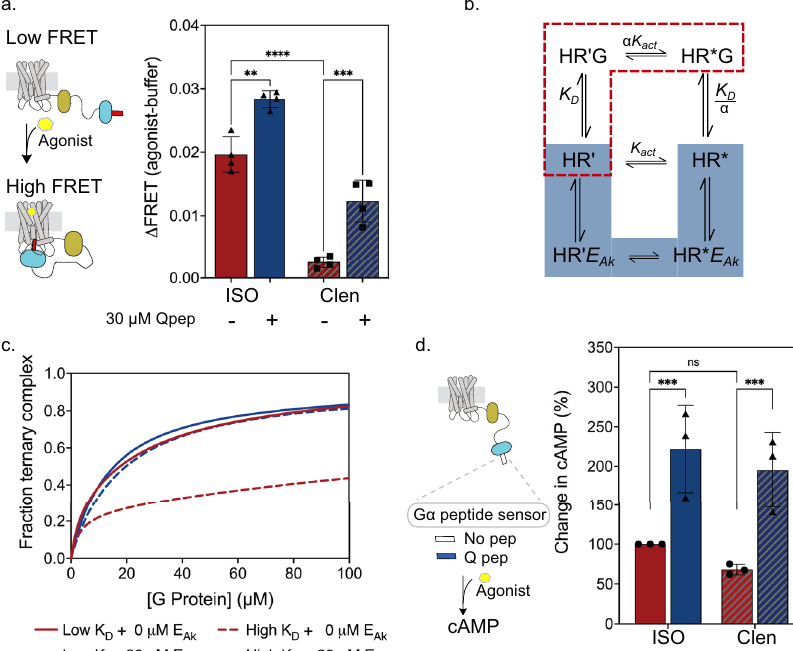
Fig. 3 EAk disproportionately increases ternary complex formation for low ef fi cacy agonists. a Change in FRET ratio for β 2AR-Spep sensors in the presence of high ef fi cacy (100 μ M ISO, red) and low ef fi cacy (100 μ M clen, red dashed) ligands. Decreased Δ FRET due to clen stimulation is increased with the addition of 30 μ M Qpep (blue dashed). Data shows the mean + /- standard deviation from 3 independent membrane preparations of SPASM sensors ( n = 3) ** p = 0.0011, *** p = 0.0003, **** p < 0.0001 in two way ANOVA with Tukey ’ s multiple comparisons test. b Extended model, highlighting G protein binding af fi nity for HR ’ G ( K D ) and HR*G ( K D / α ), and receptor interconversion constants ( K act and α K act ). c Lower K D ( K D = 30 μ M, red) increases ternary complex formation compared to high K D ( K D = 300 μ M, red dashed). The addition of 30 μ M E Ak increases ternary complex with both low K D (blue) and high K D (blue dashed), with a greater effect with high K D values. K D/ α is kept constant through all conditions ( K D / α = 0.75 μ M). Additional agonist ef fi cacy modeling in Supplementary Fig 10. d cAMP accumulation in cells transfected with β 2AR-no peptide or β 2AR-Qpep SPASM sensors after 5 min of stimulation with either high ef fi cacy (10 μ M ISO) or low ef fi cacy (10 μ M clen) ligand. Change in cAMP is normalized to ISO with no Qpep as 100%. Data show the mean + / – standard deviation for 3 independent experiments ( n = 3) *** p = 0.0007 in 2-way ANOVA with Tukey ’ s multiple comparisons test. Source data are provided in the Source Data